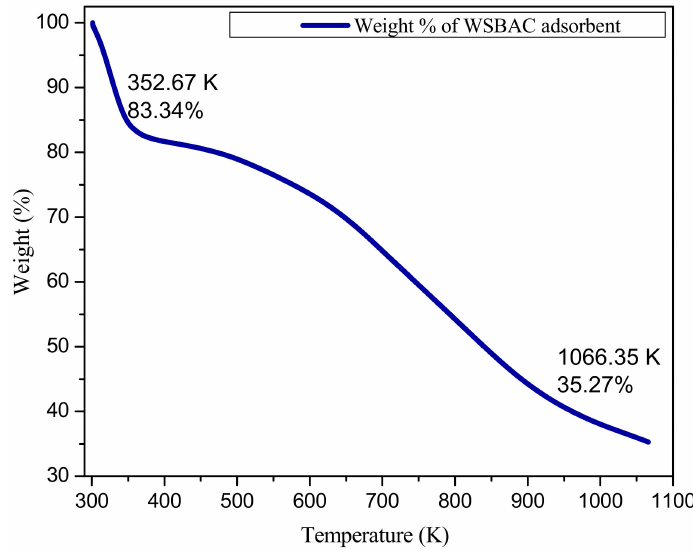
Figure 6. Thermogravimetric analysis (TGA) of WSBAC adsorbent before RBBR dye adsorption.